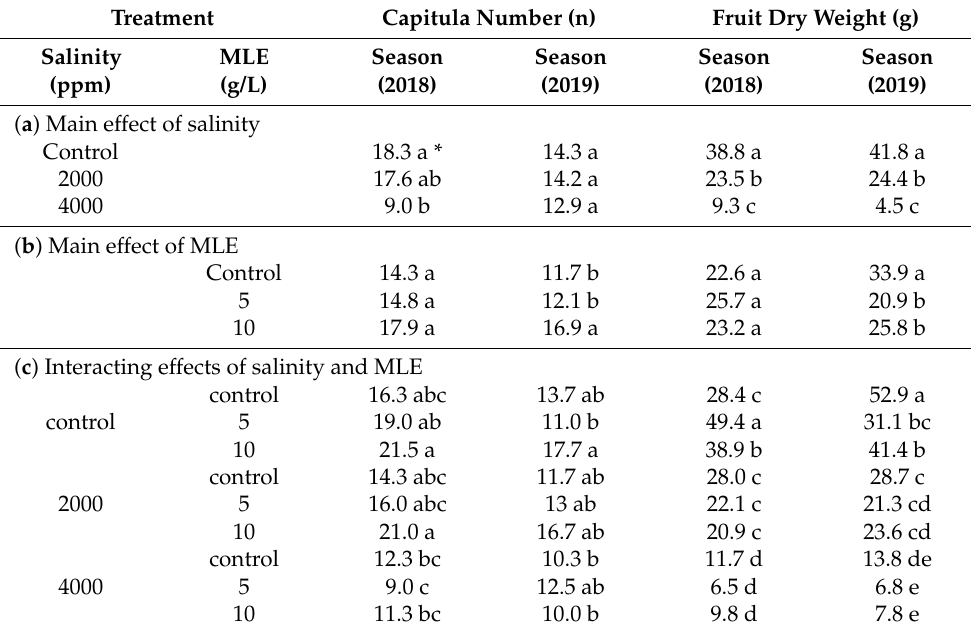
Table 5. Effects of salinity levels, Moringa oleifera leaf extract (MLE) concentrations, and their interactions on S. marianum capitula number (n) and fruit dry weight (g) during the 2018 and 2019 planting